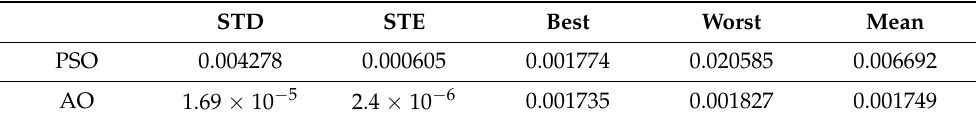
Table 6. Statistical results of convergence characteristics: Shark El-Ouinate site. STD